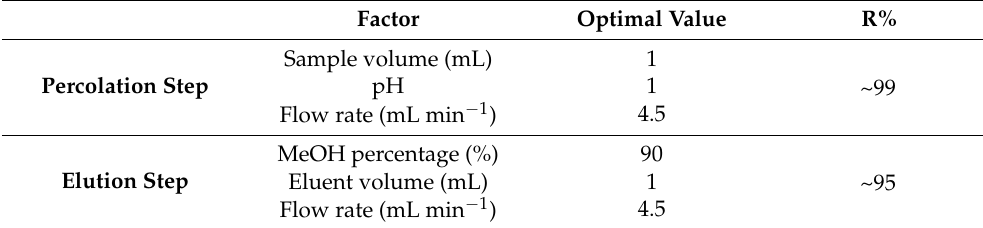
Table 7. Optimal conditions for the SPE of BA and SA.